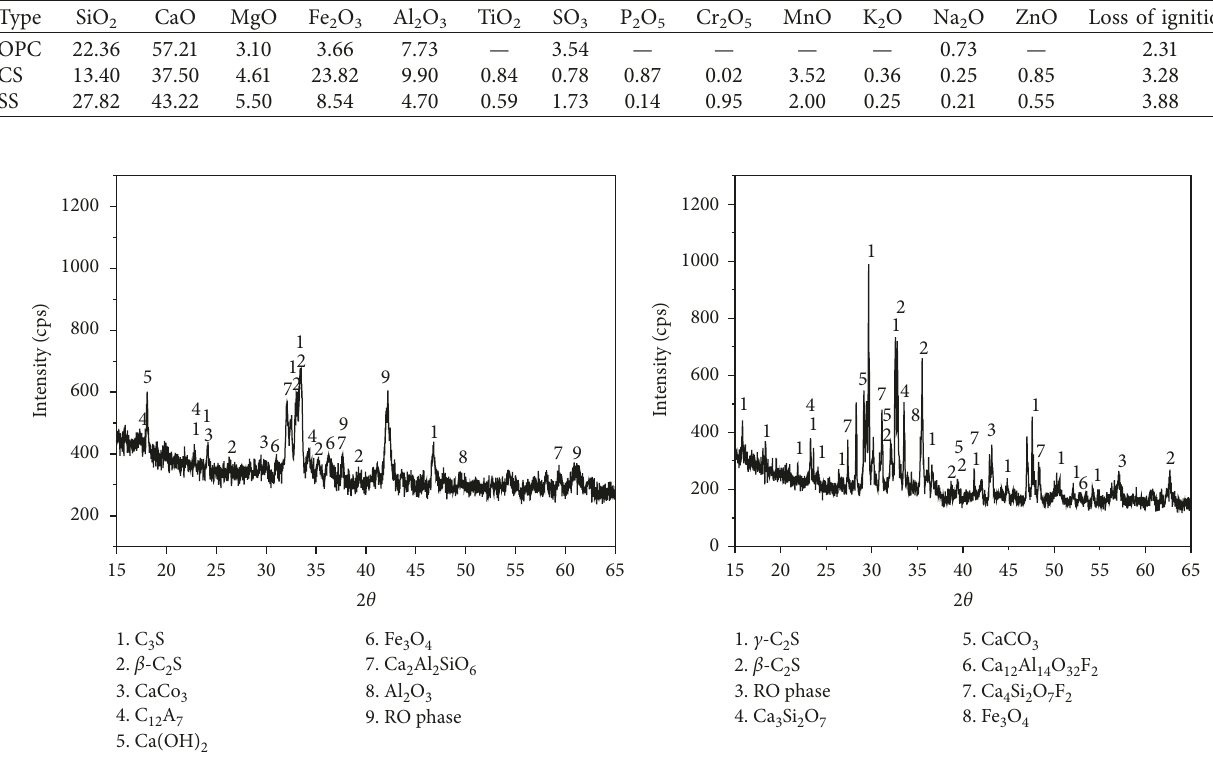
Figure 1: The mineralogical composition of CS (a) and SS